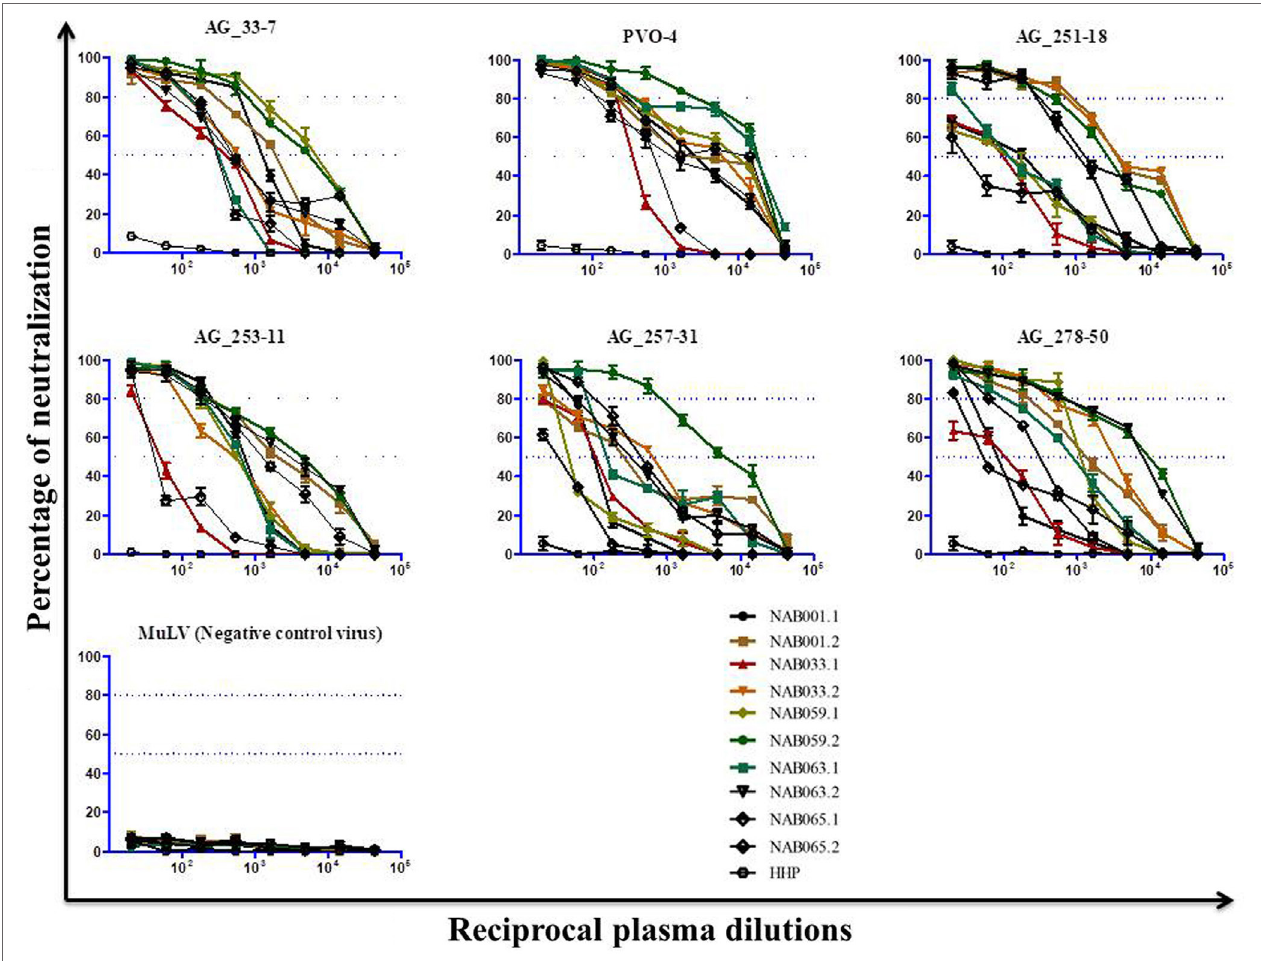
FigUre 2 | Neutralization activity of the follow-up plasma samples ( n = 5) against tier-3 pseudoviruses. Neutralization titration (dilutions 1:20 to 1:43,740) analysis was performed against 6 tier-3 pseudoviruses in TZM-bl